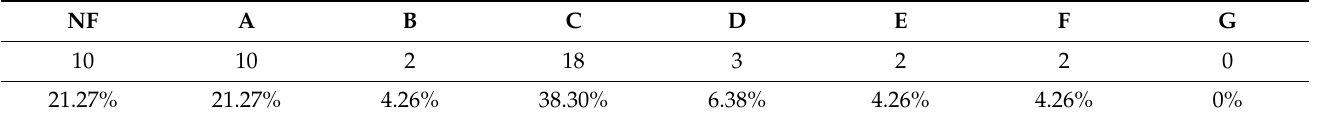
Table 4. The first row shows the total number of instances per class. The second row shows the share of the class in the